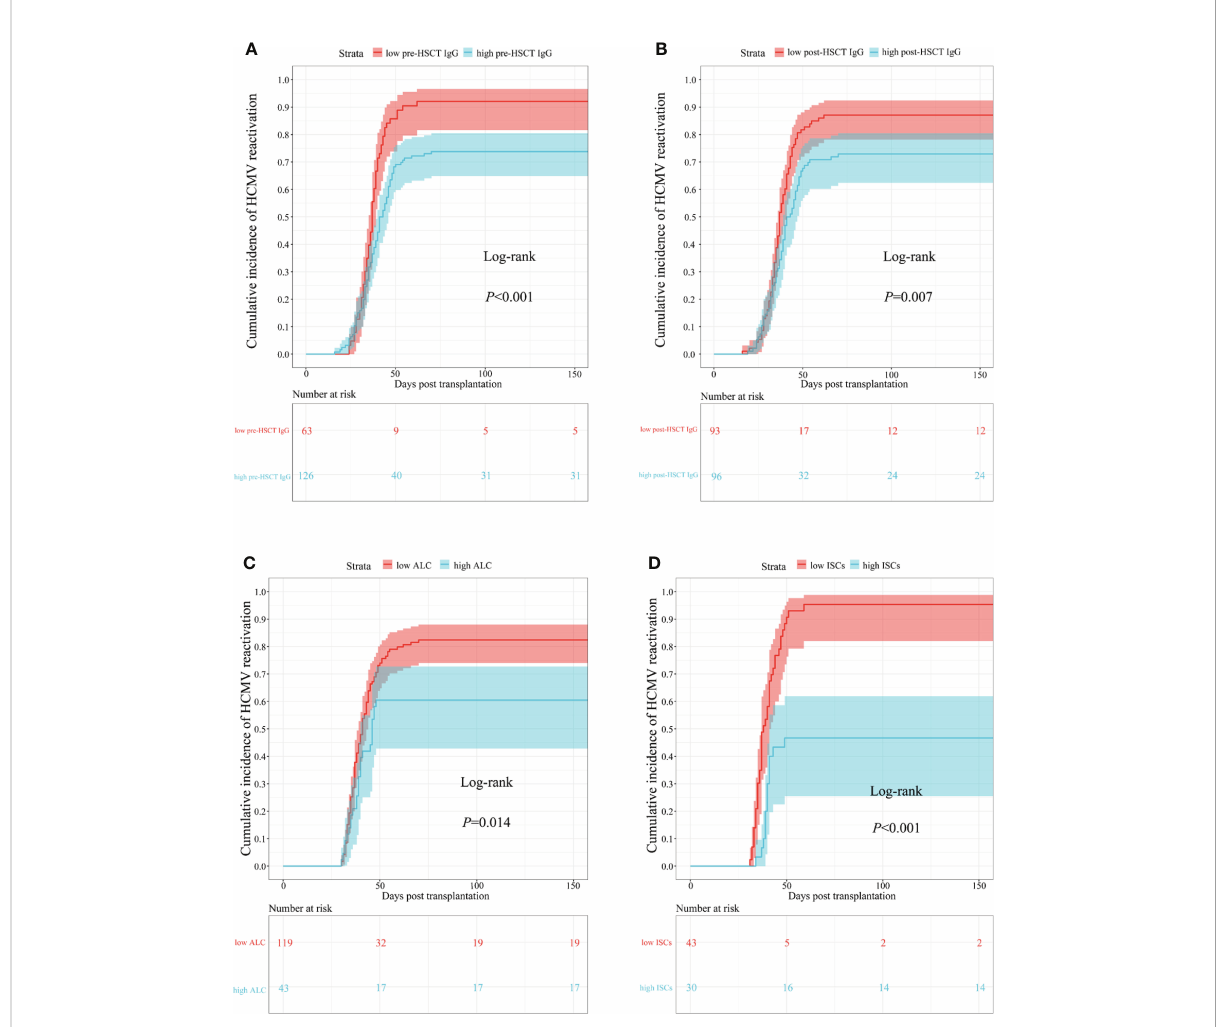
FIGURE 3 Cumulative incidence curves of time to occur HCMV reactivation in different biomarkers. (A) pre-transplant; (B) post-transplant HCMV IgG antibody concentrations; (C) ALC; (D) ISCs. HSCT, hematopoietic stem cell transplant; HCMV, human cytomegalovirus; ALC, absolute lymphocyte count; ISCs, HCMV speci fi c IFN- g secreting